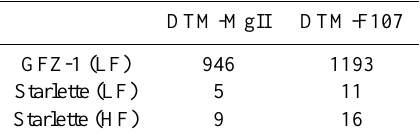
Table 2. Comparison between the observed and computed position of GFZ-1 and Starlette during low (LF) and high (HF) solar activity. The mean RMS of the SLR residuals is given, in